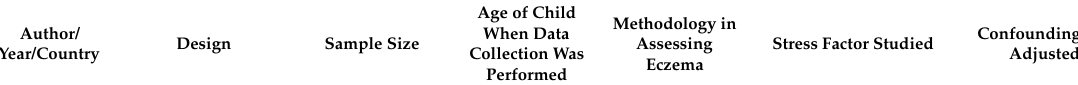
such associations were observed if we compare maternal stress and anxiety with diagnosis of AD using strict